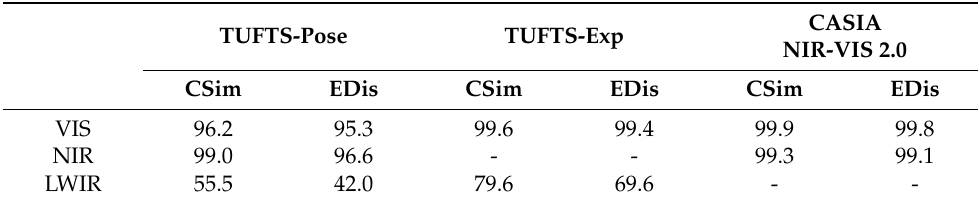
Table 7. Rank-1 results (in %) achieved in the face recognition task with the cosine similarity (CSim) and Euclidean Distance